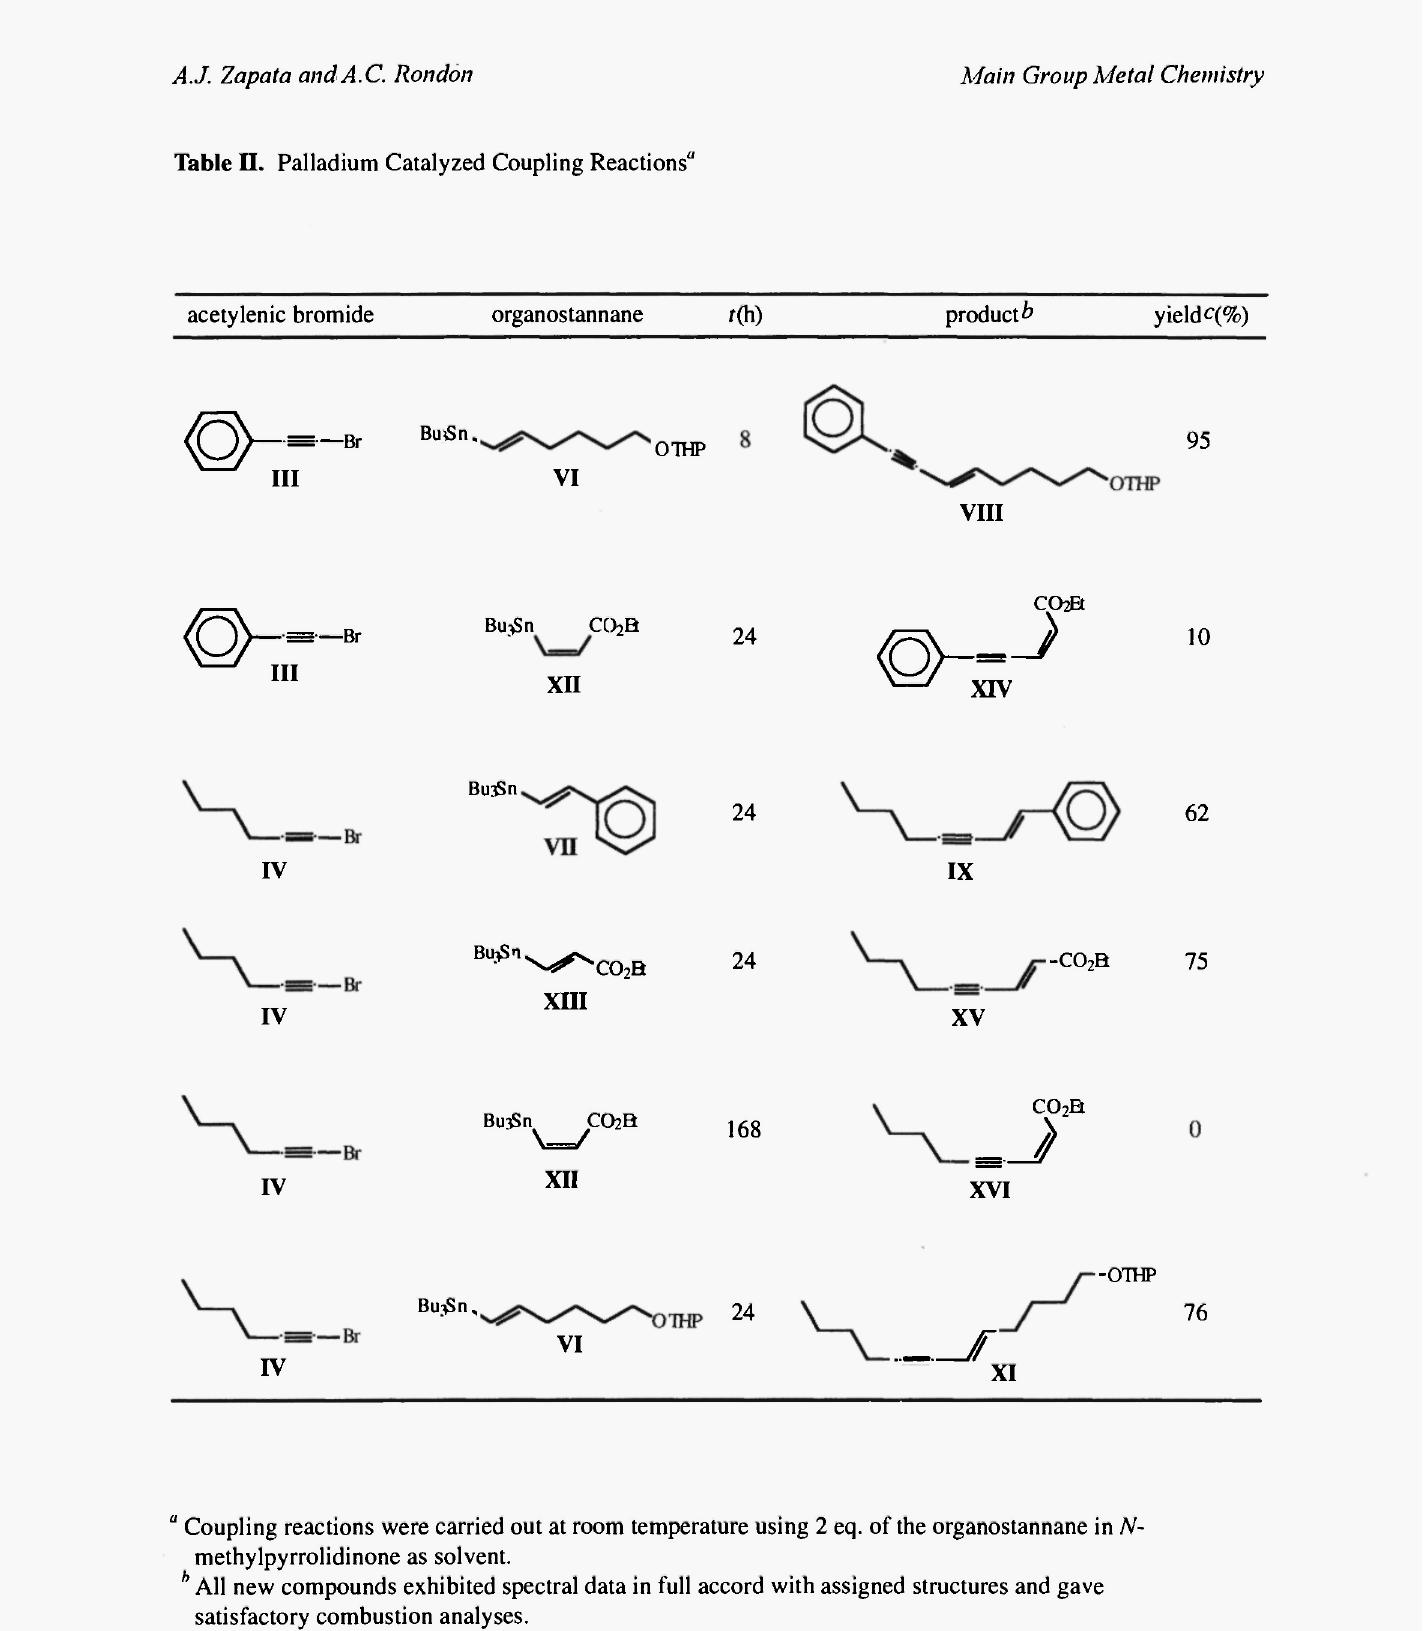
Table Π. Palladium Catalyzed Coupling